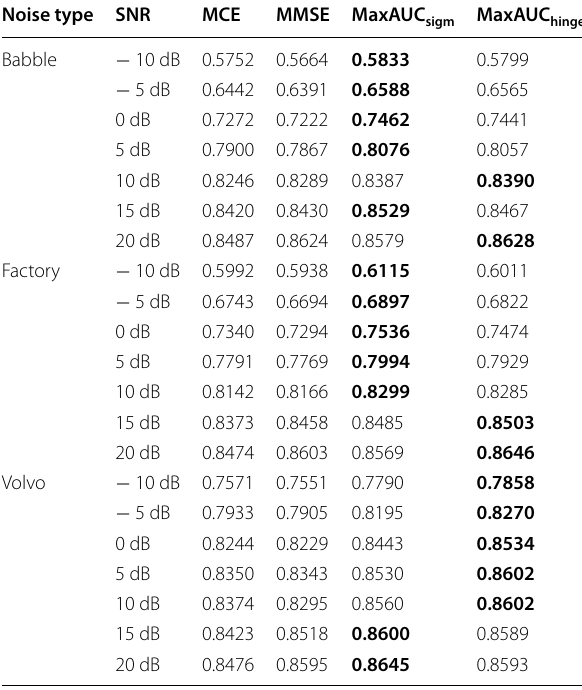
Table 6 AUC results of the comparison VADs with the BLSTM model and STFT acoustic feature on the Noisy‑CHiME‑4 test dataset, when the Chinese Noisy‑THCHS‑30 dataset was used as the training